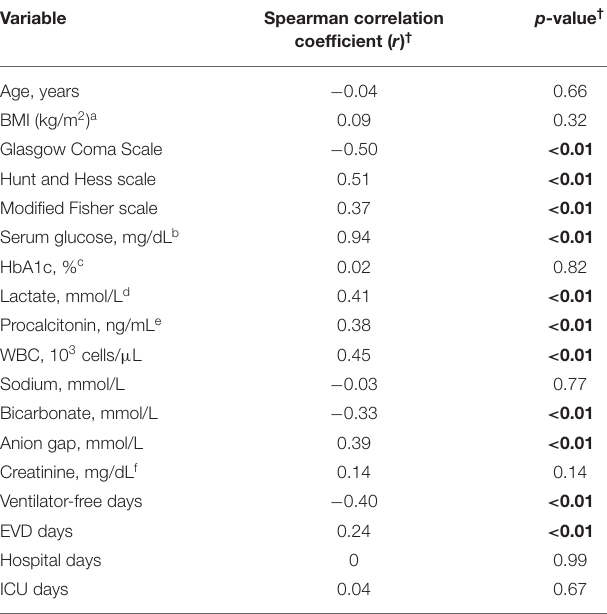
TABLE 2 | Spearman correlation between admission glycemic gap and patient characteristics and outcomes. Variable